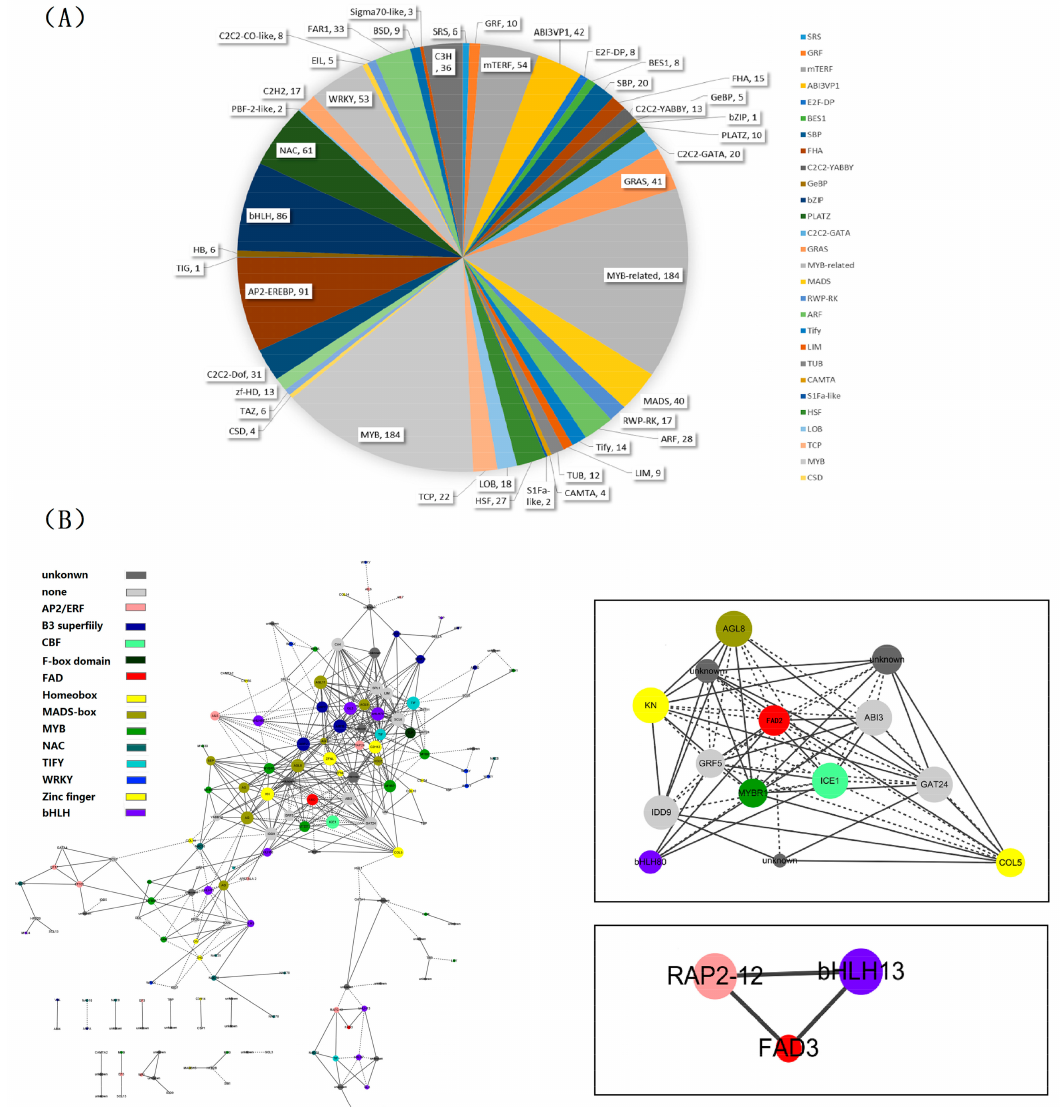
Figure 4. Transcription factor analysis. ( A ) Distribution of transcription factor (TF) families; ( B ) Coexpression network of transcript factors and fatty acid desaturase (FAD). The TF module was presented by Cytoscape v3.4.10. The rectangle indicates the TFs directly related to the FAD in the network. The solid line represents positive correlation, and the dotted line represents negative